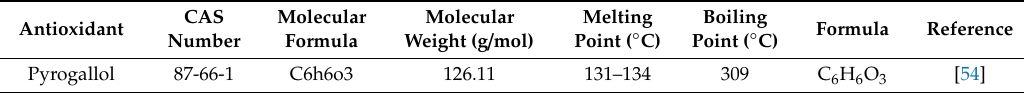
Table 2. Physicochemical properties of the antioxidant pyrogallol (PY).